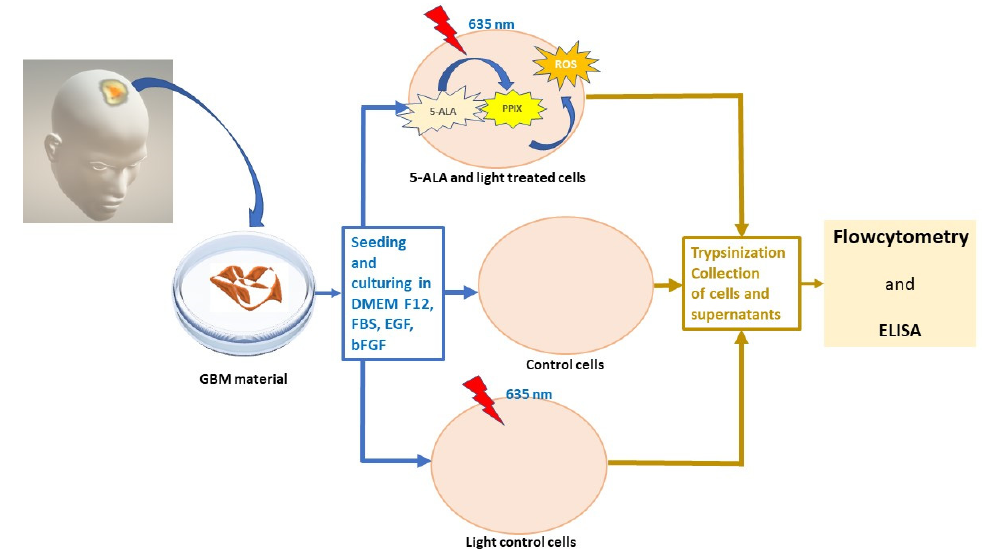
Figure 1. Photodynamic treatment of GB-MSCs. Schematic diagram of experimental steps and procedures.